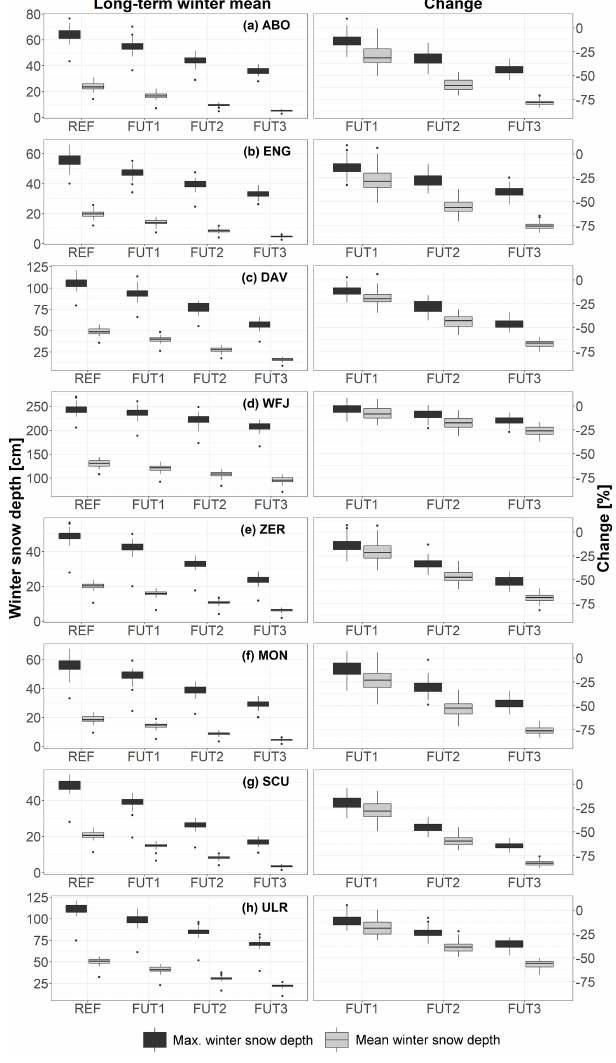
Figure 6. Winter mean maximum and mean snow depth (cm; left) for the ClimEx LE and mean changes (%; right) between the REF period 1980 to 2009 and FUT1 (2010 to 2039), FUT2 (2040 to 2069) and FUT3 (2070 to 2099) for the stations Adelboden (ABO), Engelberg (ENG), Davos (DAV), Weissfluhjoch (WFJ), Zermatt (ZER), Montana (MON), Scuol (SCU) and Ulrichen (ULR). The boxes represent the interquartile range with the median as a hori- zontal line. The whiskers represent 1.5 times the interquartile range, and the dots represent